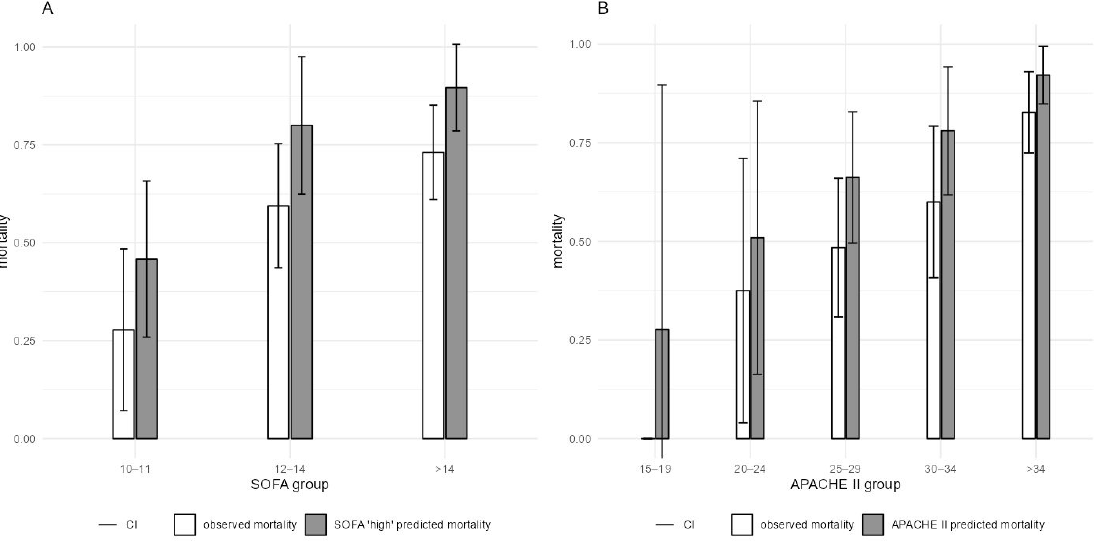
Figure 5. ICU and in-hospital mortality, stratified by the highest SOFA and APACHE II at the first CytoSorb treatment ( A ) Actual ICU mortality with 95% CI compared to SOFA-estimated mortality. ( B ) Actual in-hospital mortality with 95% CI compared to APACHE II-estimated mortality. CI – confidence interval. Table 5. Highest SOFA score and observed vs. predicted ICU mortality rate. Comparison for grouped ICU mortality by Chi-squared test.